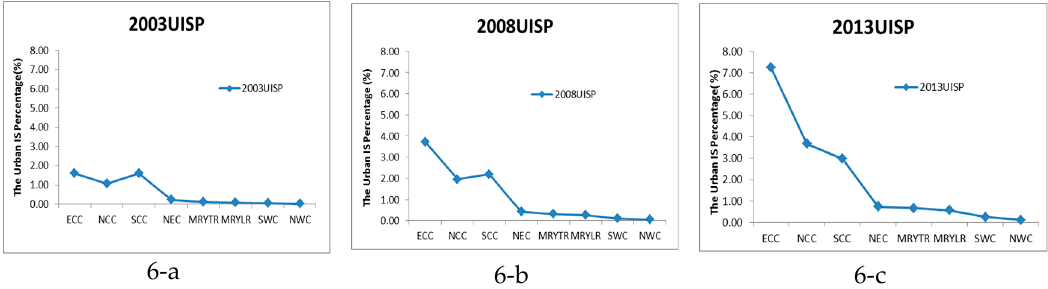
2008 ,(b) 2008 to 2013 and (c) 2003 to 2013 in the eight regions.